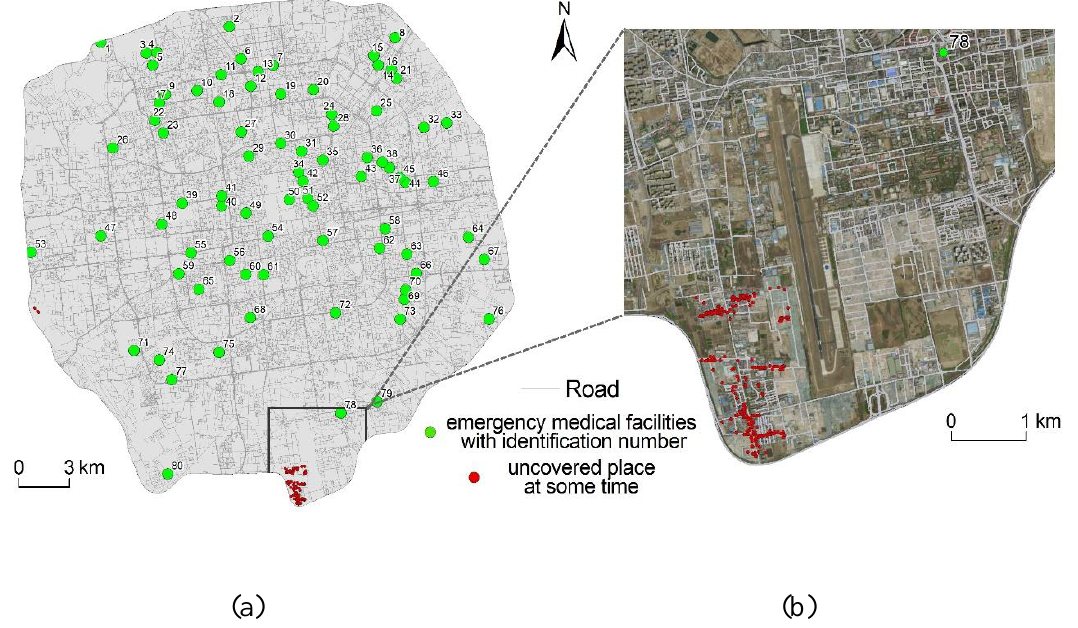
Figure 6. The blind coverage area of emergency medical facilities at some times: ( a ) the whole study area; ( b ) the Southern Fifth Ring Road Jingxian Bridge area.